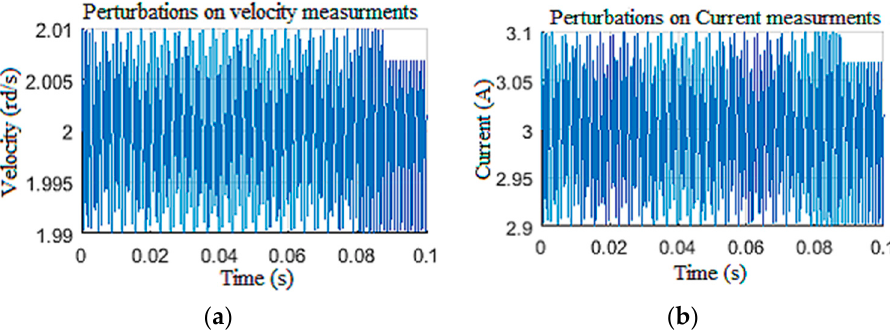
Figure 17. Perturbations in the measurement: ( a ) velocity; ( b ) current.